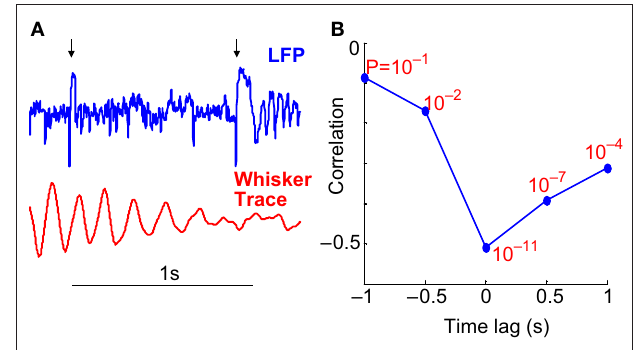
FIGURE 4 | Time constant of behavioral states. (A) Example of whisking trace and LFP responses to two closely spaced microstimulations. The time of microstimulation is indicated using black arrows. The signifi cant difference in LFP response shows that evoked responses to microstimulation are rapidly modulated by changes in motor behavior. (B) The correlation between LFP oscillation power and whisking strength is plotted at different time lags with the correlation ( R ) on the Y -axis and the ‘ P ’ value of each correlation indicated in red. Note that the correlations are negative with the highest magnitude of correlation ( − 0.50) occurring at 0 lag. The rapid drop-off in the correlation implies rapid switching of behavioral